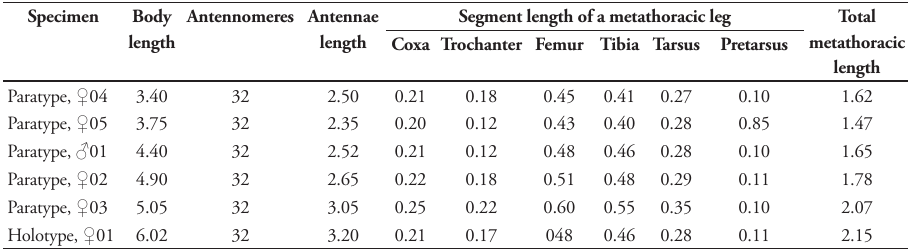
Table 1. Haplocampa wagnelli Sendra, sp. n., length of the body, antennae and metathoracic leg includ- ing their segments, the cerci (units in mm), and the number of antennomeres. Specimen Antennomeres Antennae Segment length of a metathoracic leg Total length